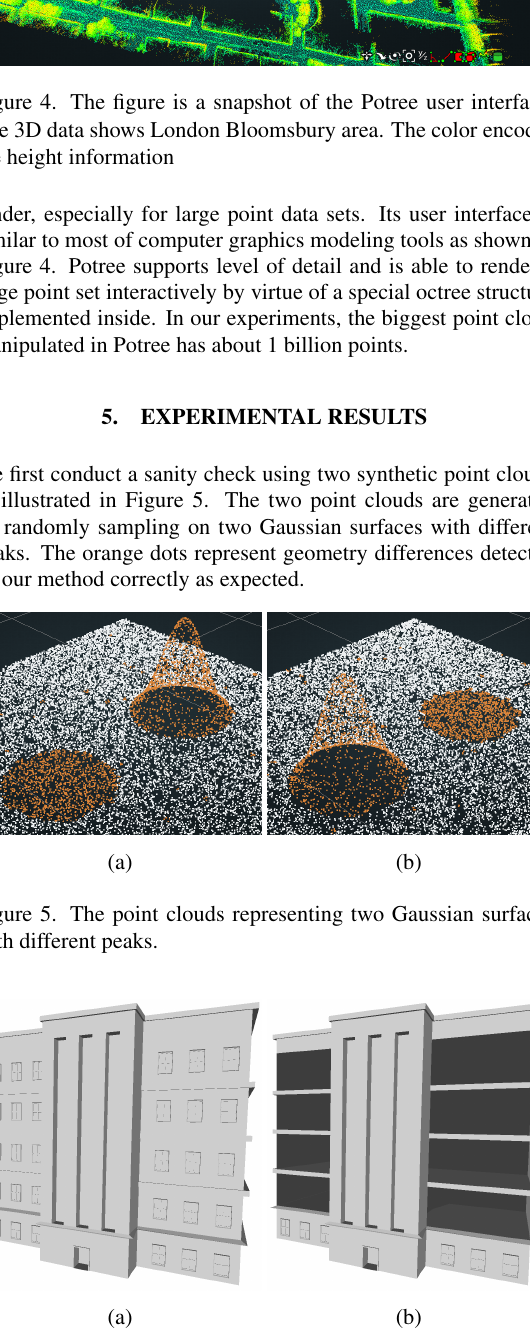
Figure 6. Two exactly same building models except the right one does not have part of the facade.